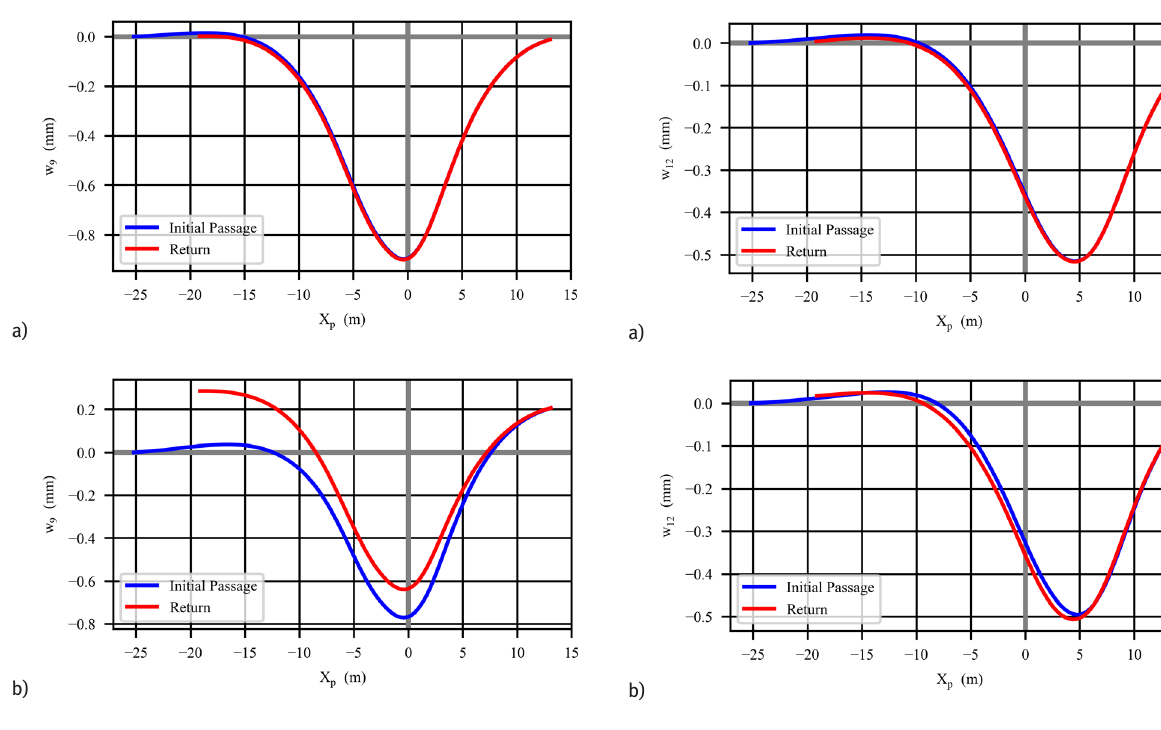
Figure 13: Vertical displacement of point No. 12 during consecutive vehicle crossings: without shell ballasting (a) and with ballasting